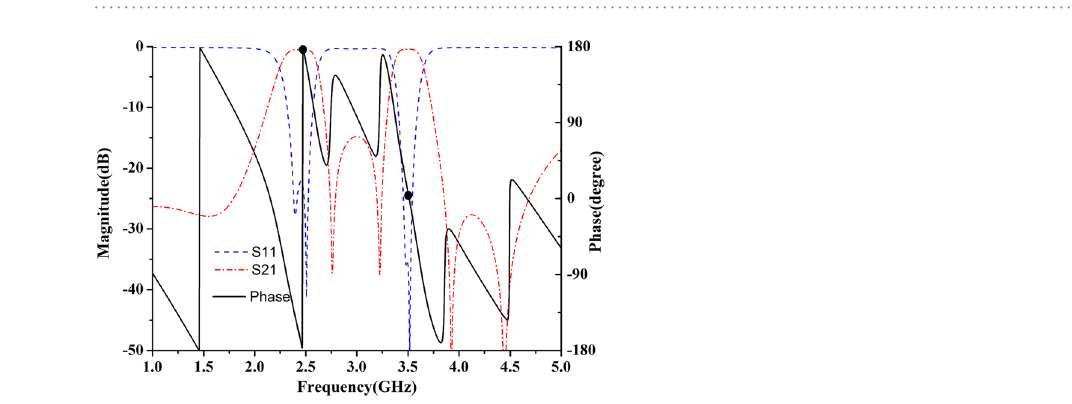
Figure 11. Equivalent circuit of dual-band filtering power divider before embed two dual-mode stub loaded resonator. ( a ) even mode. ( b ) odd mode.